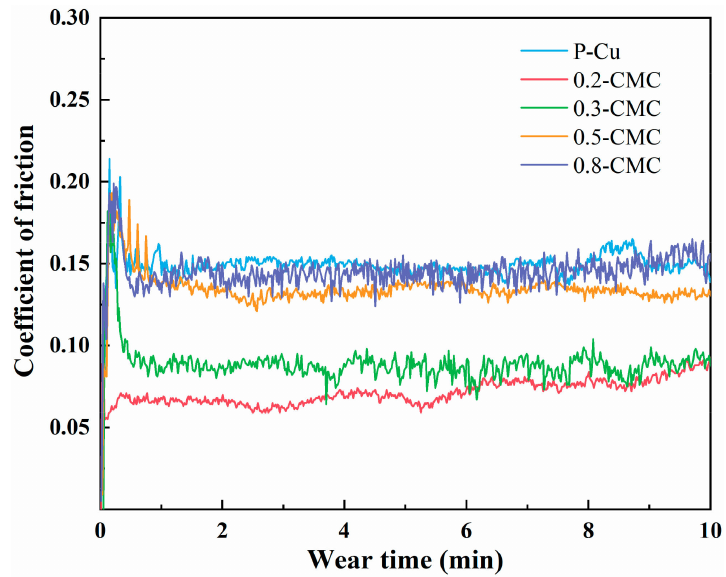
Figure 8. Coefficient of friction of CMCs with different BNNS volume fractions.